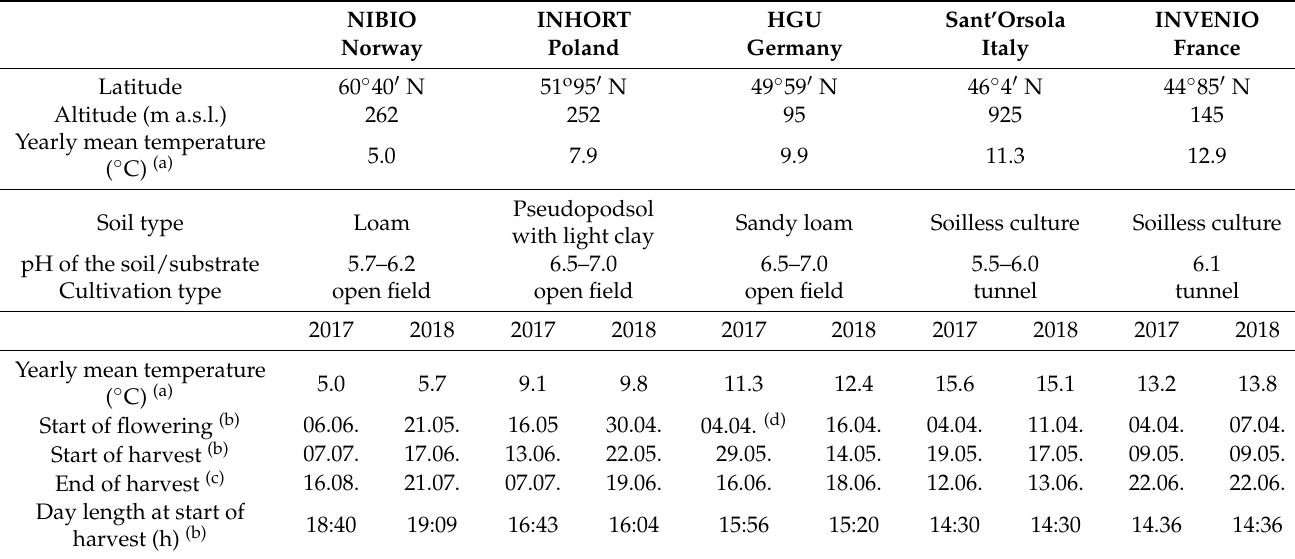
Table 1. Geographical location, soil and climatic conditions, cultivation type and harvest season for the five experimental locations in